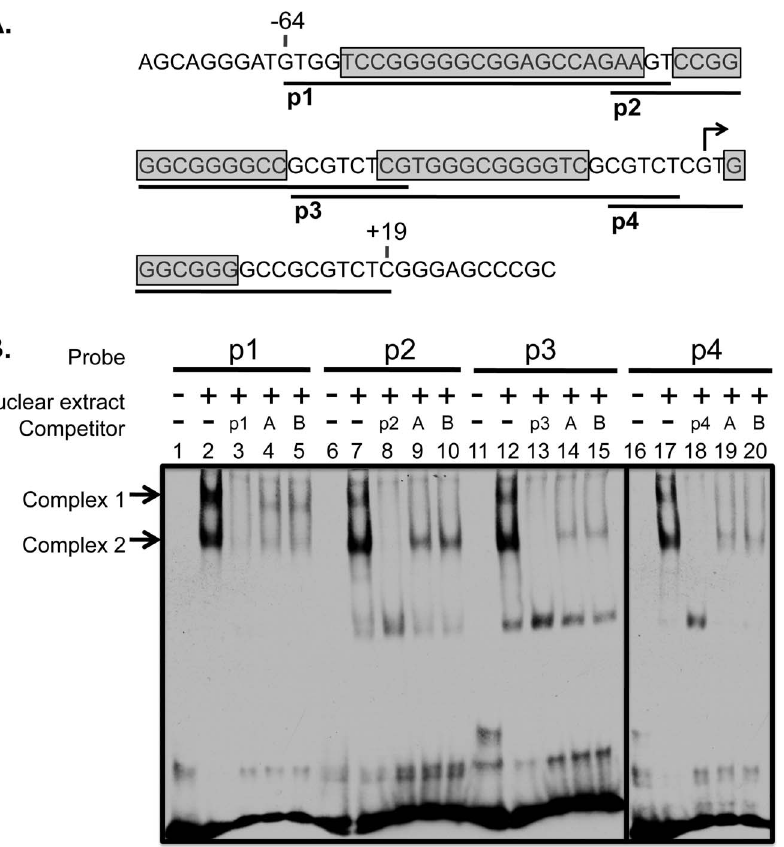
Figure 2. Electrophoretic mobility shift (EMSA) analysis of four consensus Sp1/3 binding sequences comprising the Mina P1 promoter. (A) Shown is the sequence of the Mina P1 promoter mapped to region ( 2 64/ + 19) showing the TSS (bent arrow), the four consensus Sp1/ 3 binding sequences (boxed and shaded), and probes p1–p4 each containing a single Sp1/3 site (underlined and labeled). (B) Representative EMSA assay showing nucleoprotein complexes 1 and 2 (arrows) formed by combining nuclear extracts from EL4 cells with 5 9 biotin labeled probes p1–p4 in the absence or presence of a 100-fold molar excess of unlabeled probes containing autologous (p1–p4) and heterologous (A and B corresponding to Sp1A and Sp1B, respectively, from the OX40 promoter [16]) Sp1/3 consensus sequences. Data are representative of 2 experiments.